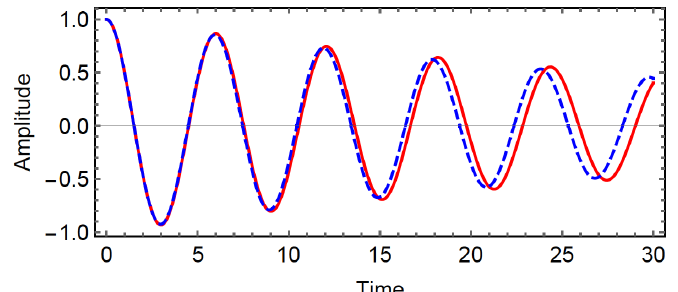
Figure 2. The red curve is the numerical solution and the dashed blue curve is the solution by the modified differential to transform method (MDTM) in Equation